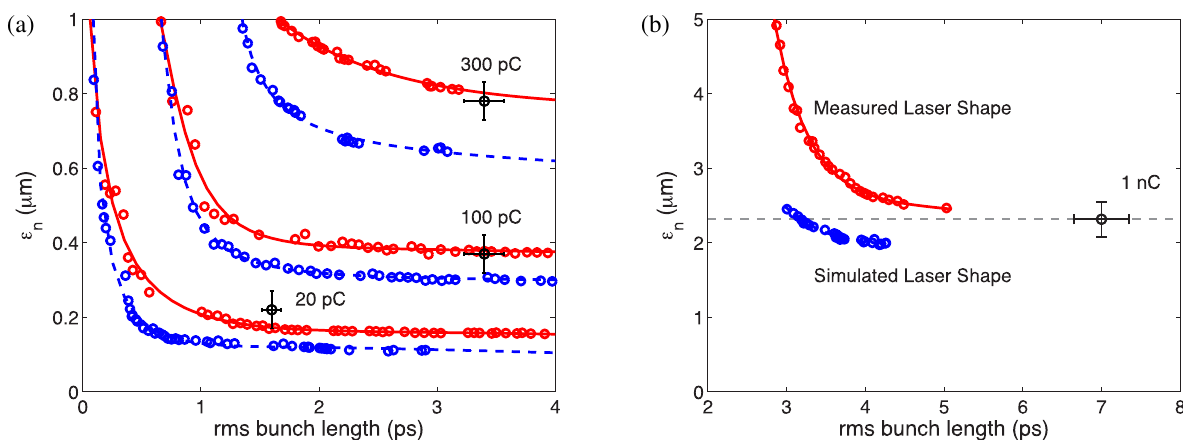
FIG. 10. Comparison of the optimal average 100% transverse emittance for 20 – 300 pC bunch charges (a) and 1 nC bunch charge (b). Shown in blue are the optimizations using an ideal, varied laser shape. In red are the optimization results using the measured transverse laser profile and fix shaping crystal angles. Measured values are shown in